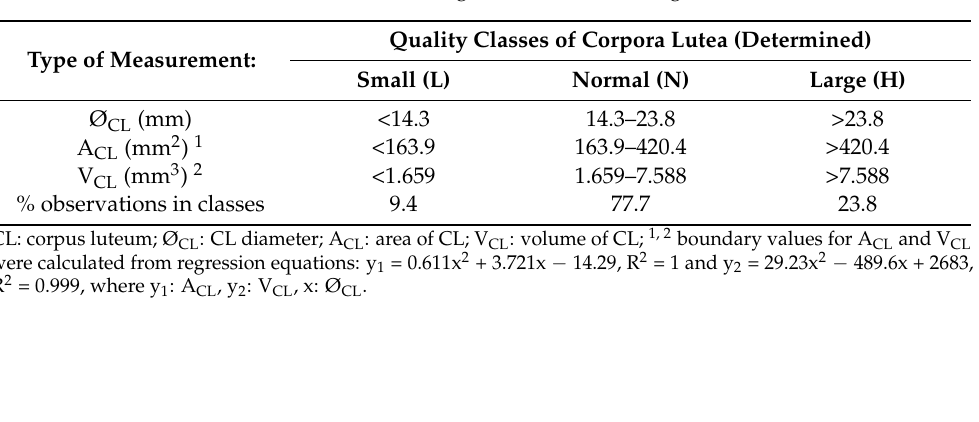
Table 6. Ranges of morphometric measurements of compact CLs determined based on the curve of normal distribution of their diameter (according to the curve from Figure 1, n =